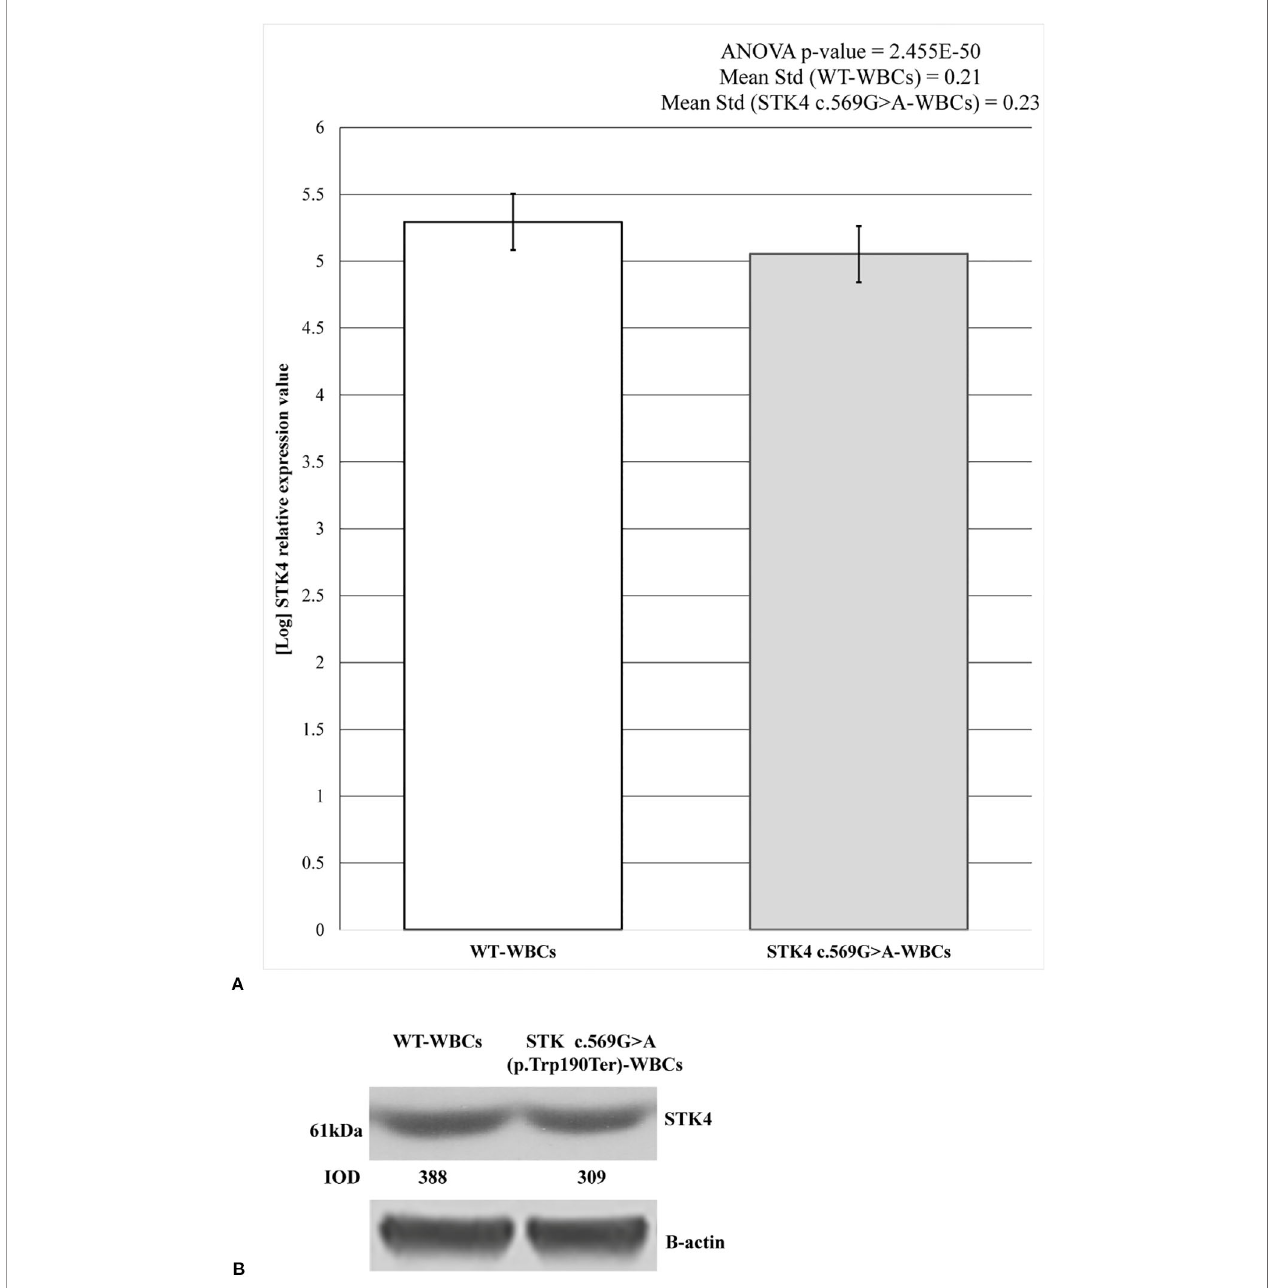
FIGURE 3 | STK4 expression values and protein detection in control white blood cells (WBCs) and c.569G > A (p.Trp190Ter) WBCs. (A) The histogram shows the logarithmic STK4 relative expression values coming from real-time (RT)-PCR experiment, compared between wild-type and mutated sample groups. As reported, ANOVA test resulted signi fi cant (p-value = 2.455E − 50). The presence of STK4 c.569G > A variant determines an expression reduction of about 20%, compared to the wild-type control. Reported values represent the mean of the three replicates. (B) Protein detection by western blot analysis showing a reduction of the STK4 protein synthesis in the heterozygous c.569G > A (p.Trp190Ter) mutation carrier. The integrated optical intensity (IOD) values are